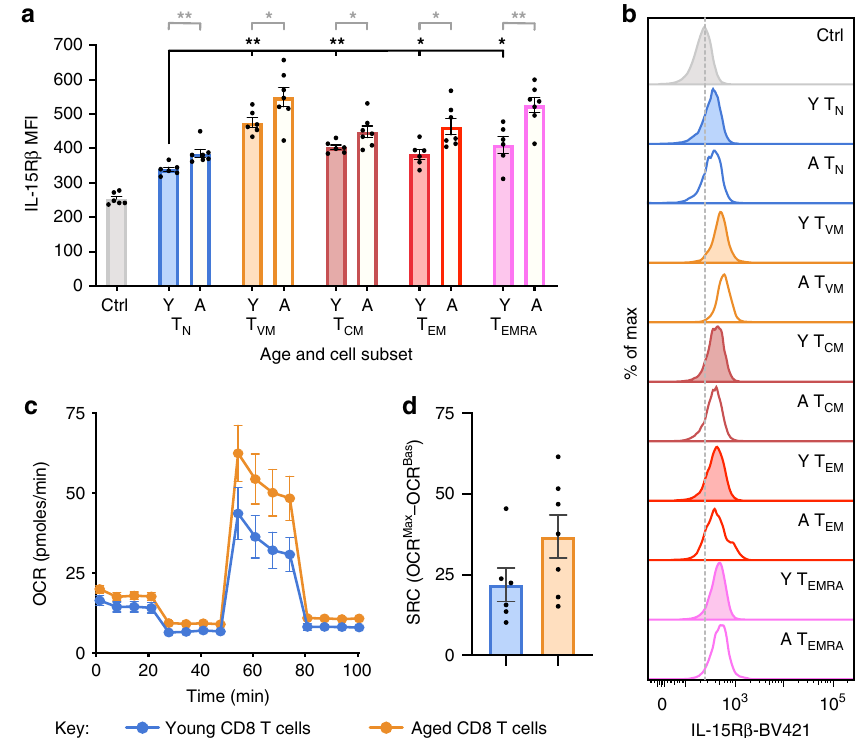
Fig. 6 Increased IL-15R β expression and SRC in older human CD8 + T cells. a IL-15R β MFI directly ex vivo on CD8 T cell subsets from individual young (20 – 30 yo) or older (60 – 80 yo) adult human donors ( n = 6 – 7) and b Representative histograms of IL-15R β expression, with expression on CD4 + T cells used as a control. c OCR for enriched CD8 + T cells from young or older human donors and d change in OCR for young or older human donors. This experiment was performed once. Bars or datapoints represent mean ± SEM. * Indicates p ≤ 0.05, ** indicates p ≤ 0.01, unpaired t